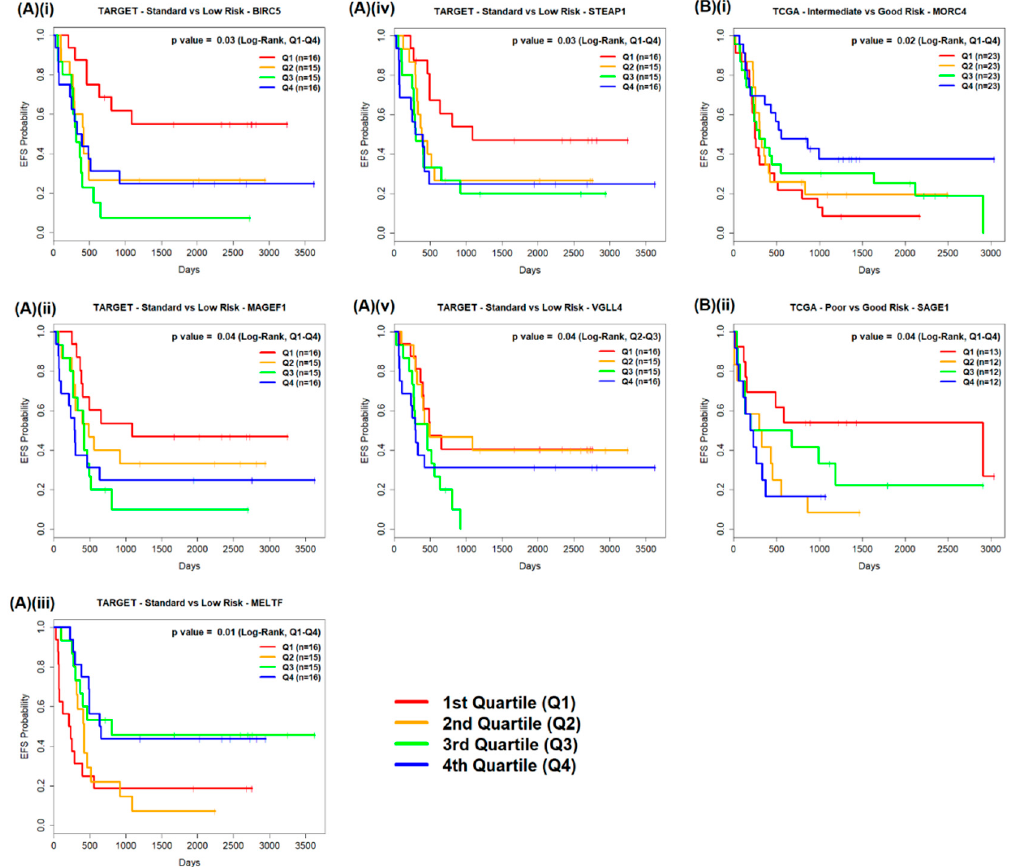
Figure 3. Significant impacts of gene expression levels (divided into quartiles) on patient EFS. ( A ) TARGET study patients across the standard and low risk subgroups were found to have significant differences in EFS when comparing quartile expression levels of ( i ) BIRC5 ; ( ii ) MAGEF1 ; ( iii ) MELTF ; ( iv ) STEAP1 and ( v ) VGLL4 ; ( B ) TCGA study patients across the intermediate and good risk subgroups showed significant di ff erences in EFS when comparing quartile expression levels of ( i ) MORC4